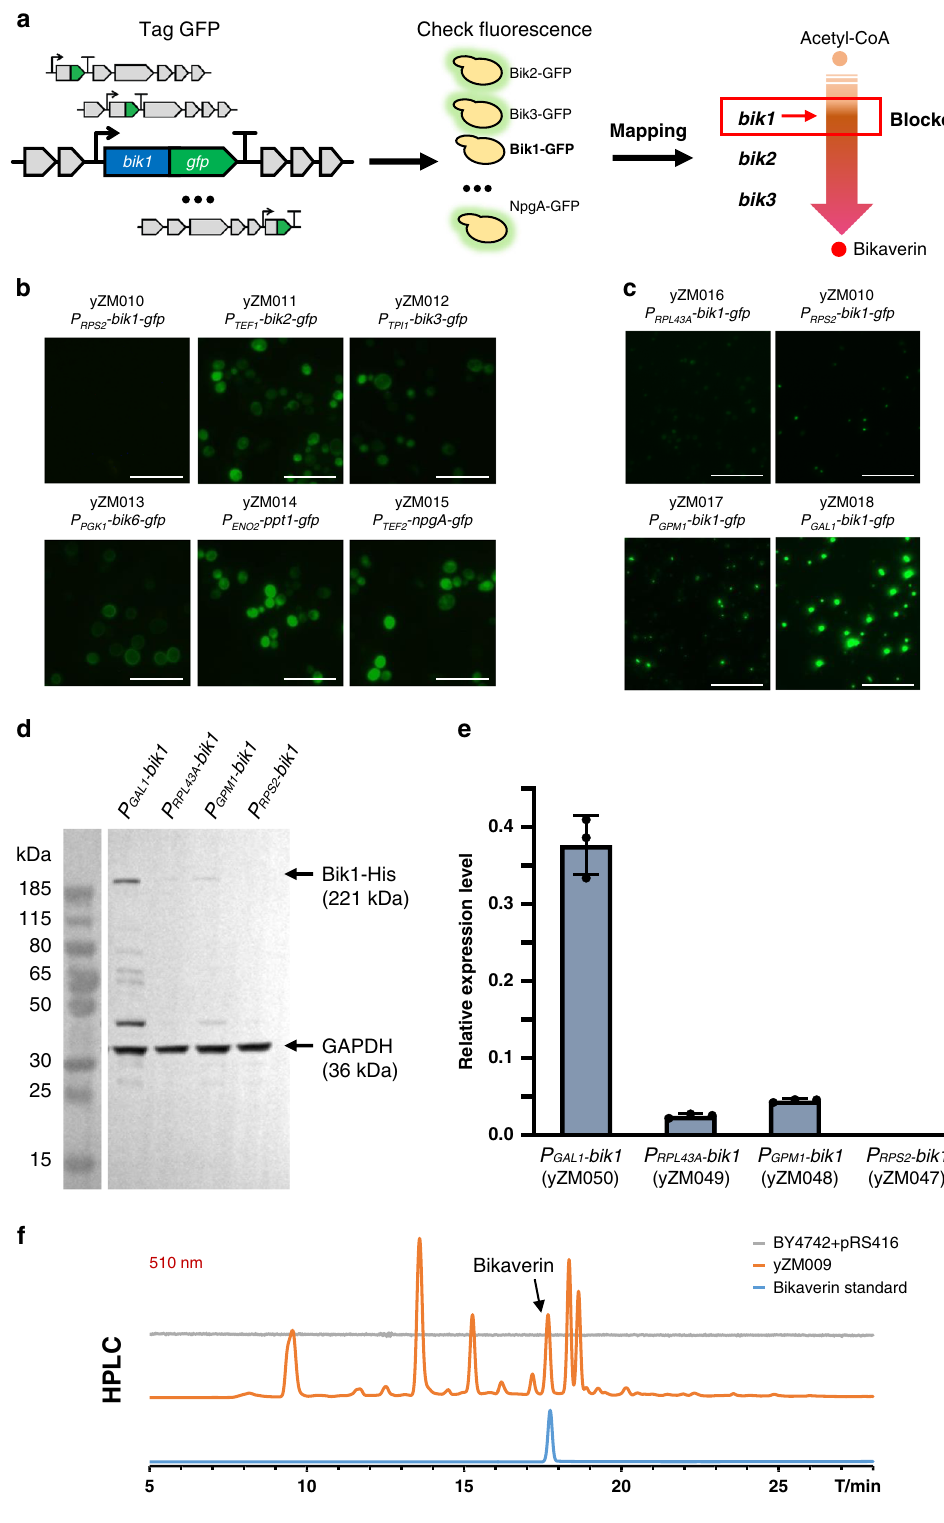
(Fig. 4b). As expected, pre-bikaverin ( m/z 325.06) ( 1 ) was detected in all strains containing bik1 (Fig. 4b and Supplementary Fig. 5). Oxo-pre-bikaverin ( m/z 339.04) ( 2 ), the